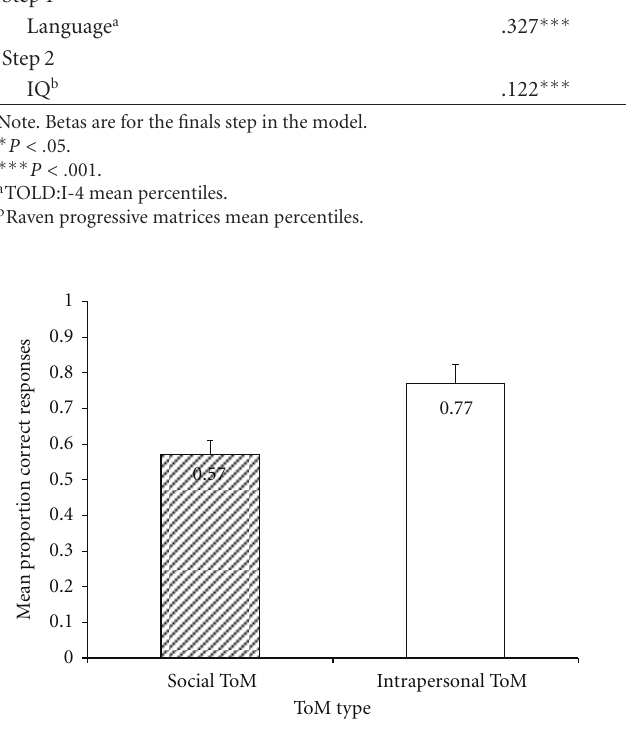
Figure 1: Mean Social and Intrapersonal ToM scores for full sam- ple.